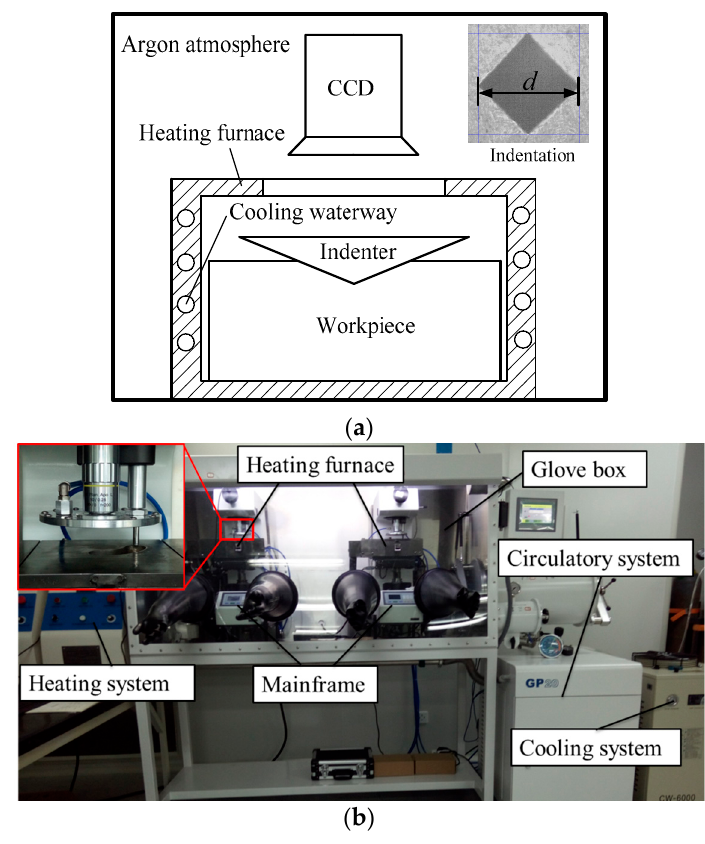
Figure 3. High-temperature hardness test principle ( a ) and equipment ( b ).